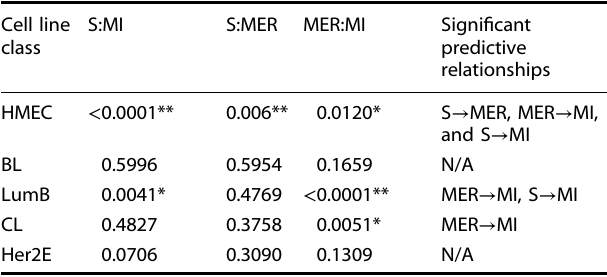
Breast cancer cell lines exhibit impaired cell cycle regulation and S/G 2 /M progression kinetics . Associations between the S:MI, S:MER, and MI:MER growth parameters were assessed for each class. Signi fi cant correlations are shown in the right column. Only the HMEC class showed signi fi cant associations among all three parameters; all breast cancer cell line classes exhibited aberrant progression kinetics for at least one cell cycle phase transition. * p -value < 0.05, ** p -value that remains signi fi cant when controlling for false discovery rate